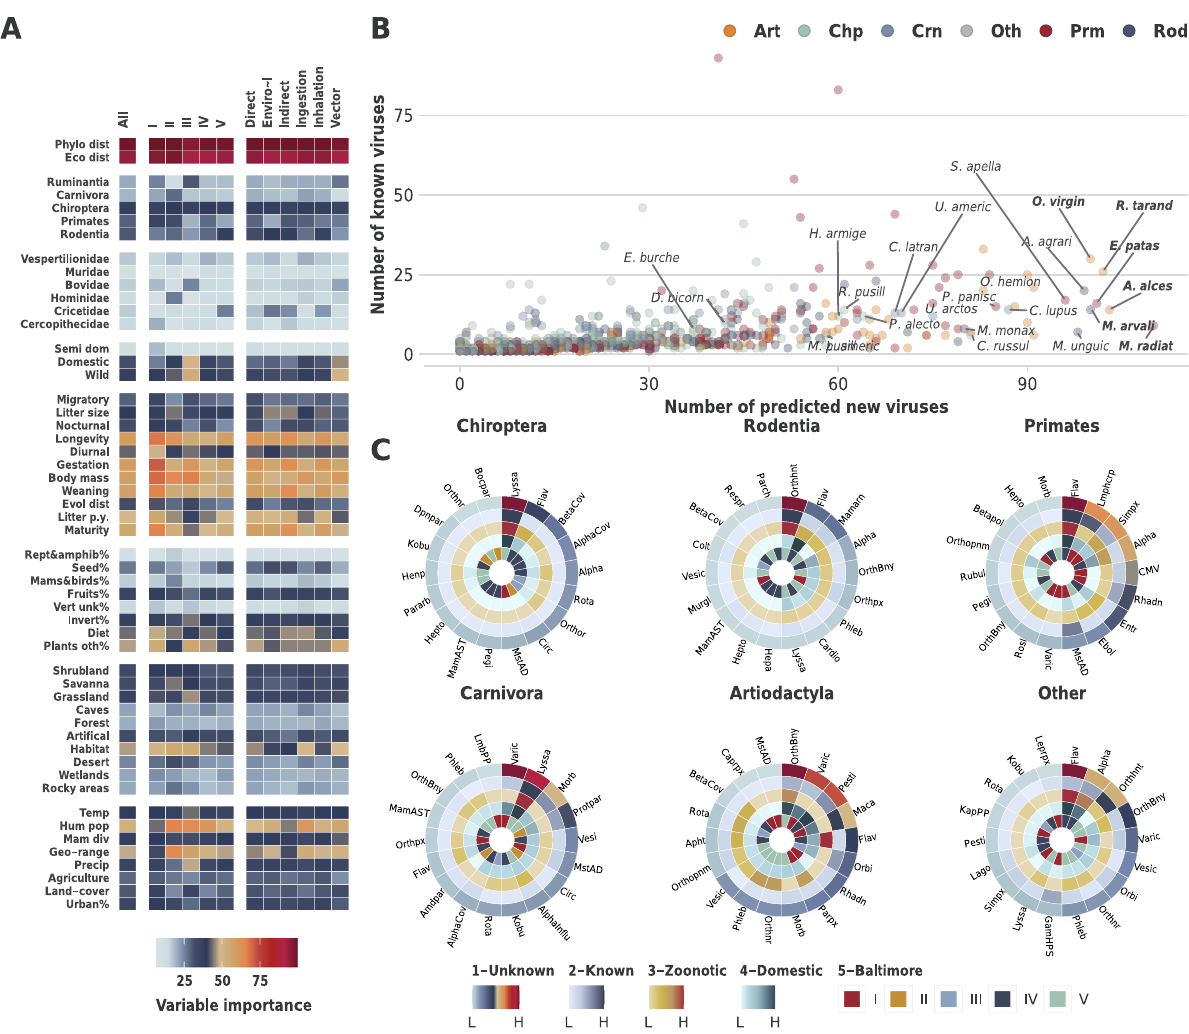
Fig. 3 Results (Mammals). Panel A Variable importance (relative contribution) of mammalian traits to viral perspective models. Variable importance is calculated for each constituent model ( n = 556) of our viral perspective (trained with mammalian features), and then aggregated (median) per each reported group (columns). Panel B Number of known and new viruses associated with each mammal. Labelled mammals are as follows: top 4 (by number of new viruses) for each of Artiodactyla, Carnivora, Chiroptera, Primates, Rodentia, and other orders. Species in bold have 100 or more predicted viruses (Supplementary Data 5). Panel C Top 18 genera (by number of predicted wild or semi-domesticated mammalian host species) in selected orders (Other indicated results for all orders not included in the fi rst fi ve circles). Each order fi gure comprises the following circles (from outside to inside): 1) Number of hosts predicted to have an association with viruses within the viral genus. 2) Number of hosts detected to have association. 3) Number of hosts predicted to harbour viral zoonoses (i.e. known or predicted to share at least one virus species with humans). 4) Number of hosts predicted to share viruses with domesticated mammals of economic signi fi cance (domesticated mammals in orders: Artiodactyla, Carnivora, Lagomorpha and Perissodactyla). 5) Baltimore classi fi cation of the selected genera (Supplementary Data 6). Supplementary Fig. 9 presents results derived with research effort into mammalian hosts and viruses included in the constituent models trained in the viral and mammalian perspectives,